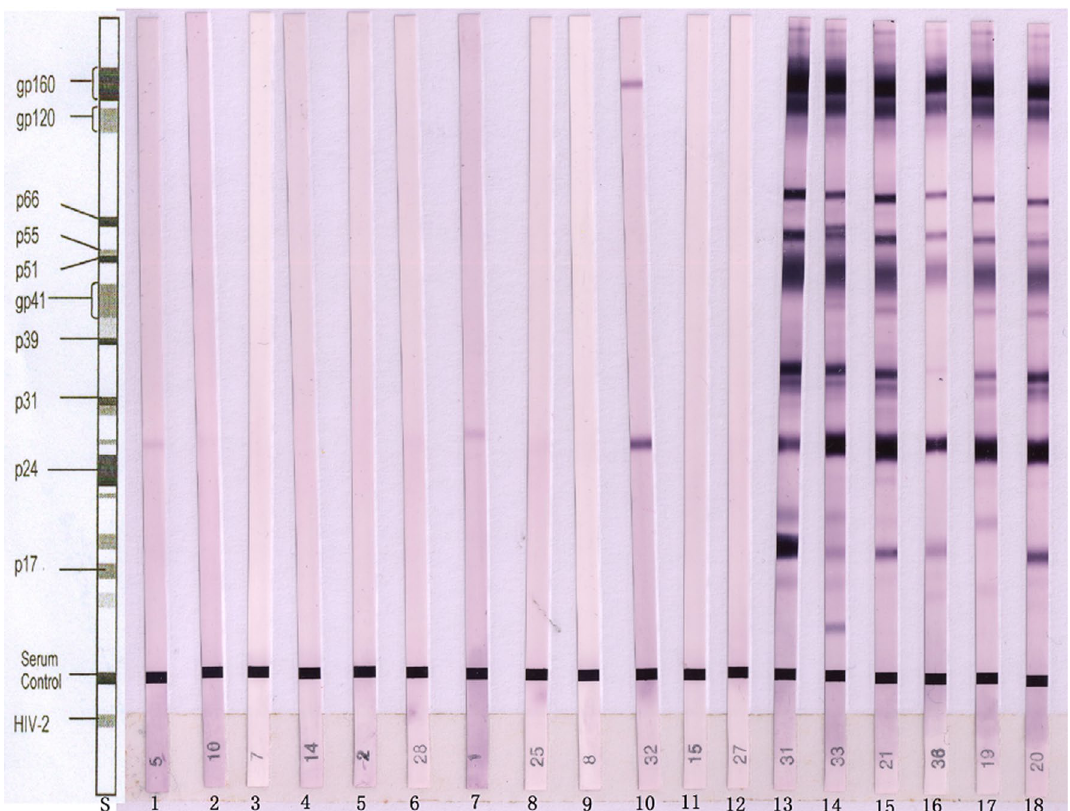
Figure 2. First western blot analysis of human sera for urea dissociation tests. S standard line. Lanes 1–6: sera obtained from patients with false-positive results, showing no bands or only the P24 band for specific antigens of HIV-1. Lanes 7–12: sera obtained from patients with early HIV infection, showing no bands or only one distinct band for specific antigens of HIV-1. Lanes 13–18: sera obtained from patients with positive results, showing more than two distinct bands for specific antigens of